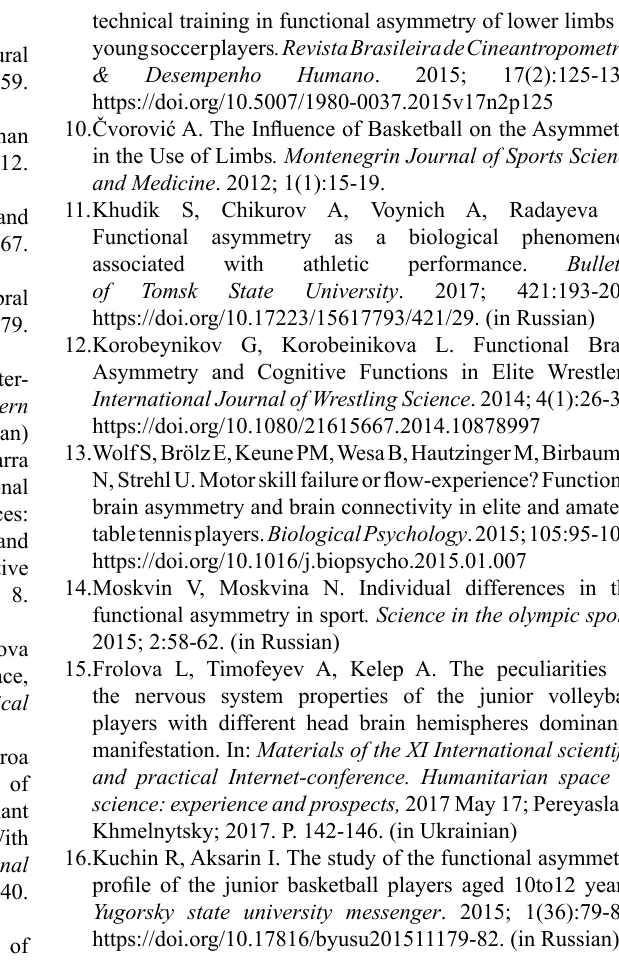
table tennis players. Biological Psychology . 2015;